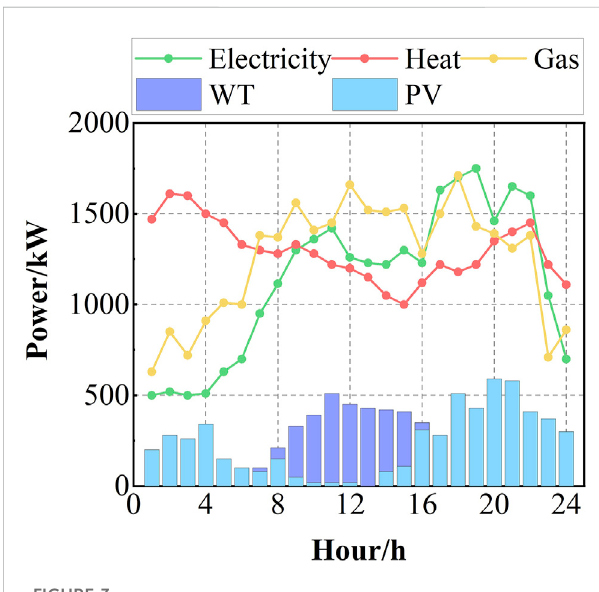
FIGURE 3 The output of PV, WT and Electricity, gas, heat load.